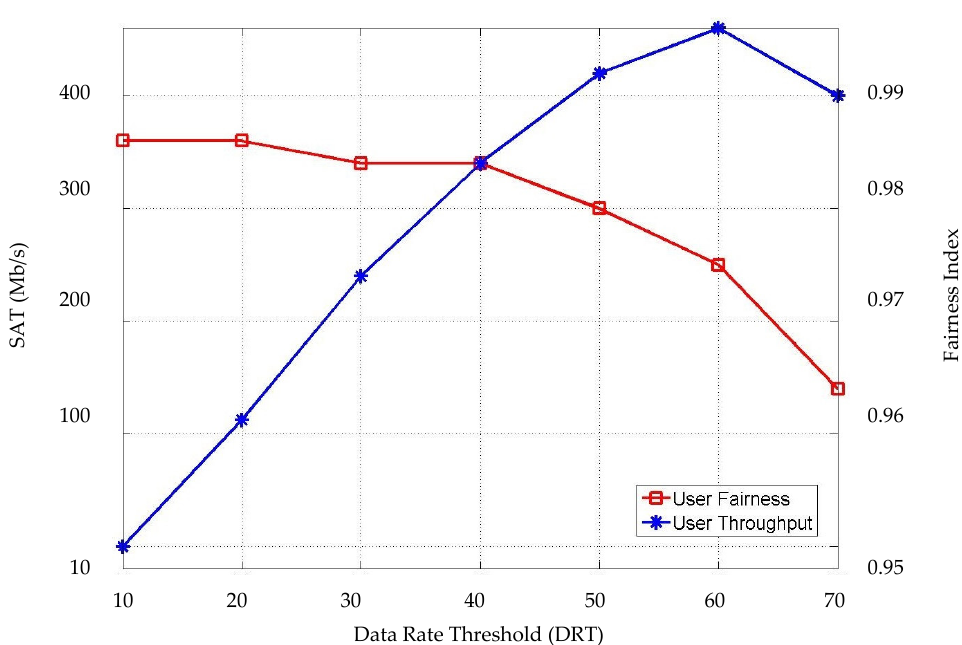
Figure 11. Average system throughput and fairness index with DRT (handover overhead 25 ms).